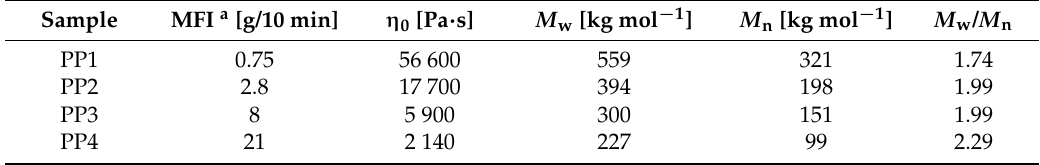
Table 1. Rheological and molecular data of the PPs used as raw materials for the study.